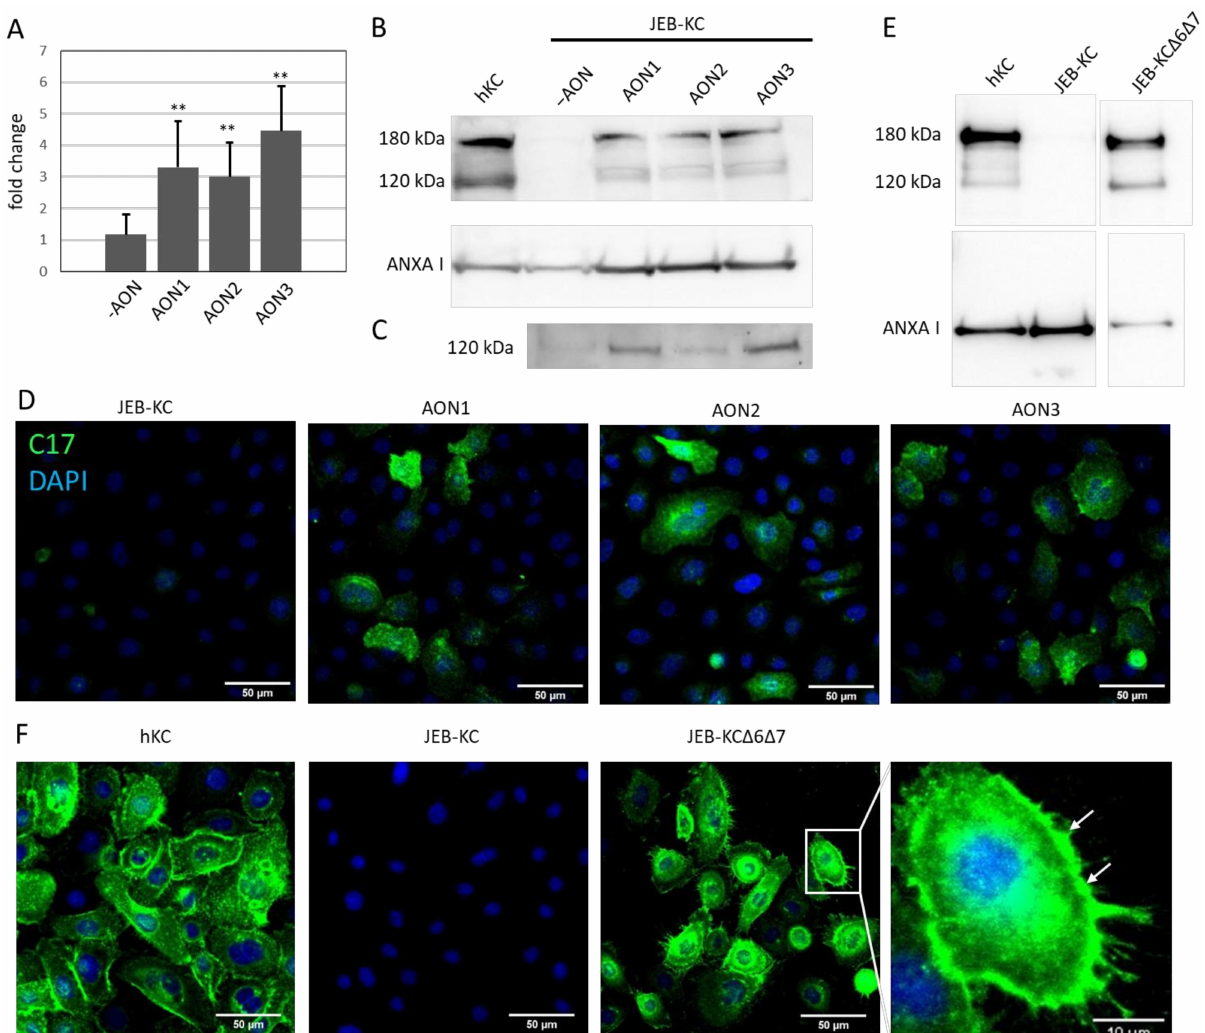
Figure 2. AON-mediated type XVII collagen expression. ( A ) Semiquantitative (Sq)RT-PCR showed the restoration of COL17A1 expression in JEB-KC upon AON treatment. GAPDH was used as the reference. Fold change over untreated JEB-KC (-AON) was calculated using the 2 − ∆∆ Ct method [23]. Unpaired, two-sided Student’s t -test was performed ( n = 6), and p ≤ 0.05 was considered significant (** p < 0.01). ( B ) Western blot analysis of whole-cell lysates. Wild-type hKC showed two distinct type XVII collagen bands at 180 and 120 kDa that are absent in JEB-KC and reappear upon AON treatment. Annexin I (ANXAI) was used as the loading control. ( C ) The 120-kDa band reappeared in a conditioned culture medium of AON-treated JEB-KC. ( D ) In immunofluorescence microscopy, the images show that the expression of type XVII collagen is restored upon AON treatment. Scale bars: 50 µ m. ( E ) Western blot analysis showed the expression of both the 120-kDa and the 180-kDa collagen 17 (C17) variants from the C17 lacking exons 6 and 7 ( ∆ 6 ∆ 7) expression cassette. ( F ) In addition, JEB ∆ 6 ∆ 7 stained positive for type XVII collagen and showed C17 integration into the cell membrane (magnified section, white arrows). Scale bars: 50 µ m, magnification: 10 µ